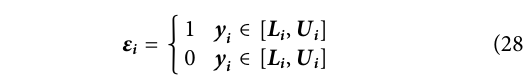
Frontiers in Energy Research |